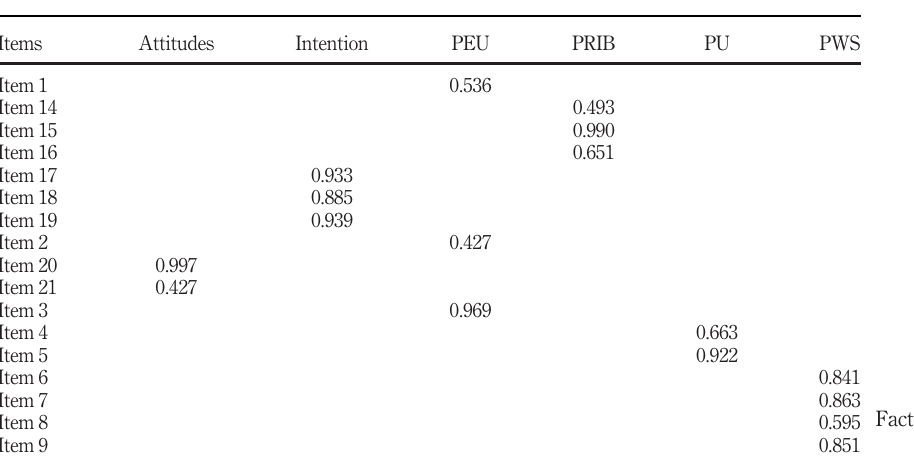
Table 6. Factor loading values for user ’ s